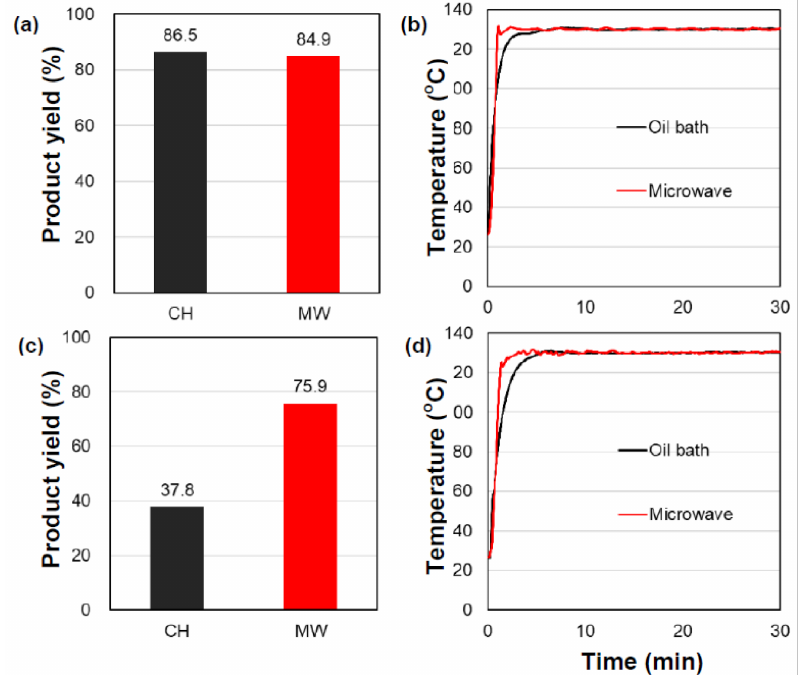
Figure 2. ( a , c ) Product yields and ( b , d ) internal temperature profiles in the synthesis of the heptyl butanoate ester in the presence of the AC-SO 3 H catalyst subjected to oil-bath heating (CH) and microwave heating (MW): ( a , b ) the moisture content in the pre-distilled second butanoic acid batch was 0.022% (second experimental run) and ( c , d ) the moisture content in the post vacuum-distilled butanoic acid was 0.058% (third experimental run).